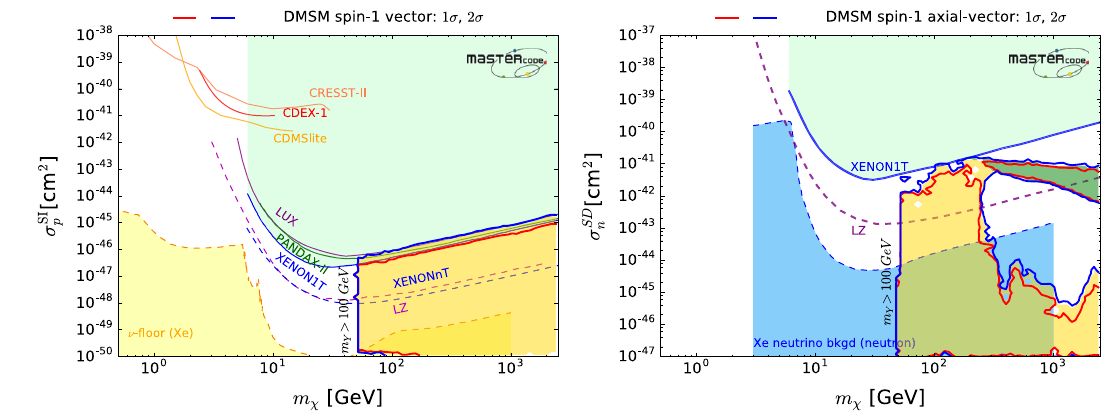
Fig. 16 Predictions for σ SI p and σ SD n after the selection 1 / 3 < g SM / g DM < 3. Left panel: Contours of the likelihood function in the ) plane for the vector-like model, showing the current upper ( m χ ,σ SI p limitsfrom theLUX[76], PANDAX-II [77]andXENON1T [78]exper- imentstogetherwiththeneutrino‘floor’[102,103](shownasthedashed orange line), and the range of σ SI p that will be probed by the upcoming